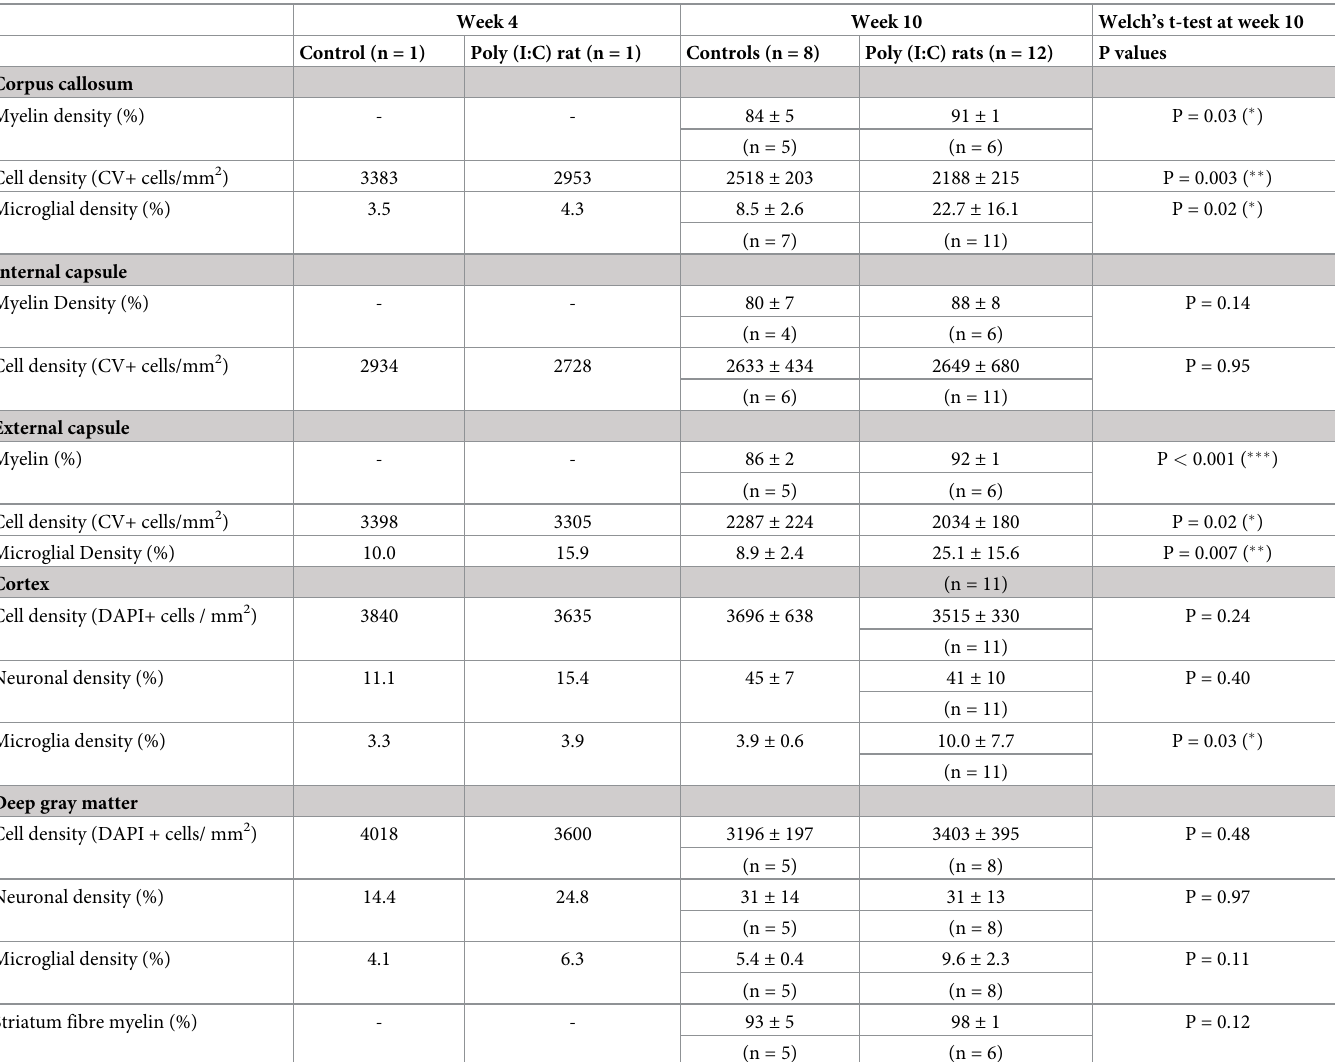
Table 1. Histological